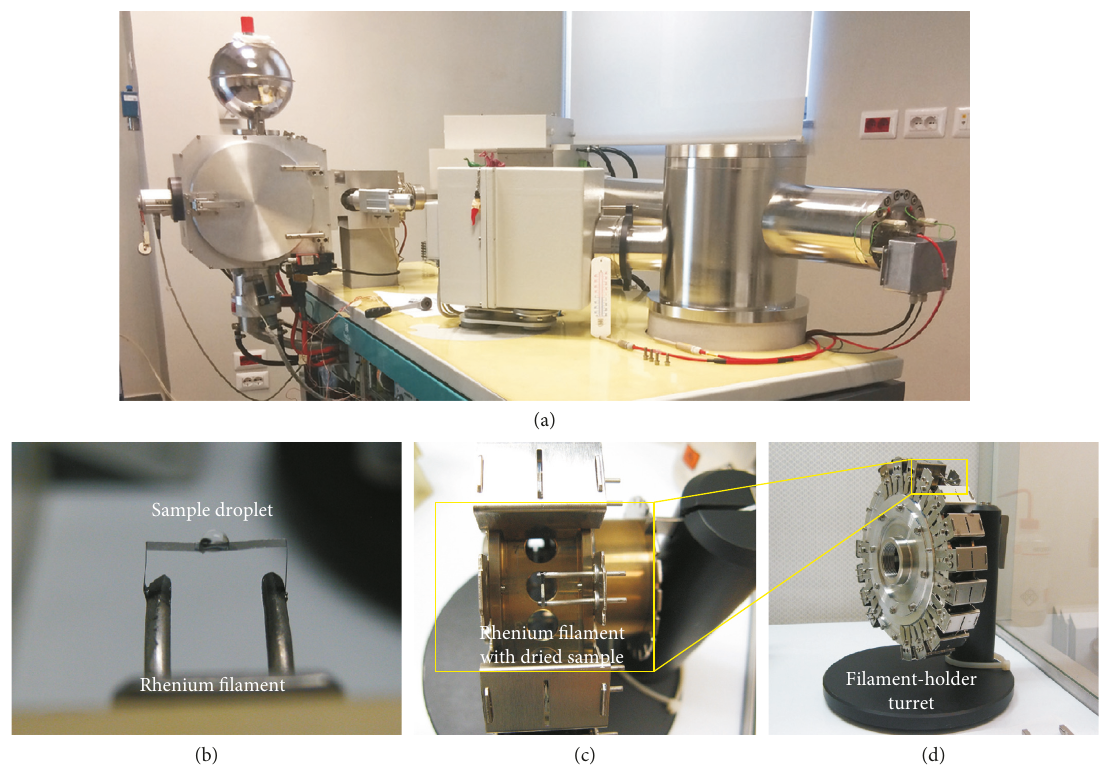
Figure 5: (a) The ThermoFinningan Triton-Ti multicollector, thermal ionization mass spectrometer (TIMS) at the University of Firenze; (b) single-rhenium filament with a sample droplet on top; (c) detail of a single filament, holding a dried sample loaded on a sample holder turret that can host 21 filament positions; (d) the turret is ready for the installation into the thermal ionization mass